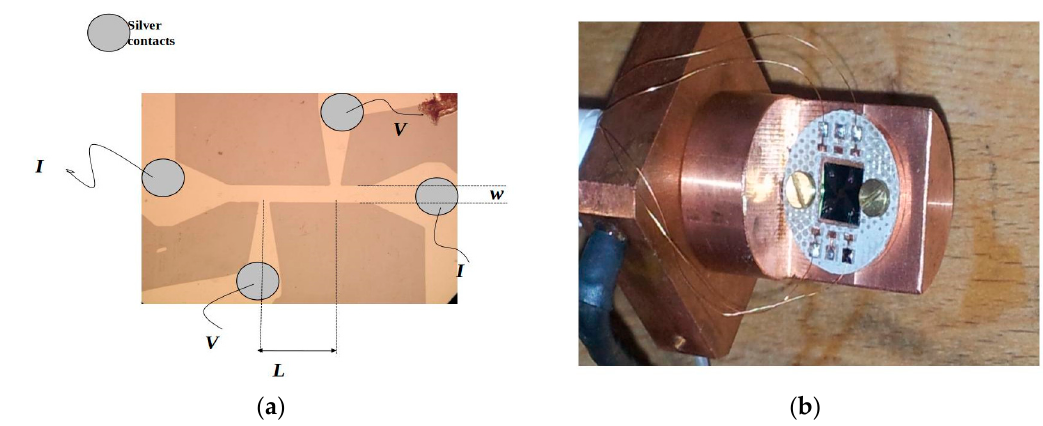
Figure 2. Picture of the real strip ( a ) with contact pads for current bias and voltage readout. The strip width is W = 10 µm. In ( b ) the strip mounted on the cold finger with all leads in place. ( a ) is reproduced from [11], with the permission of AIP Publishing).